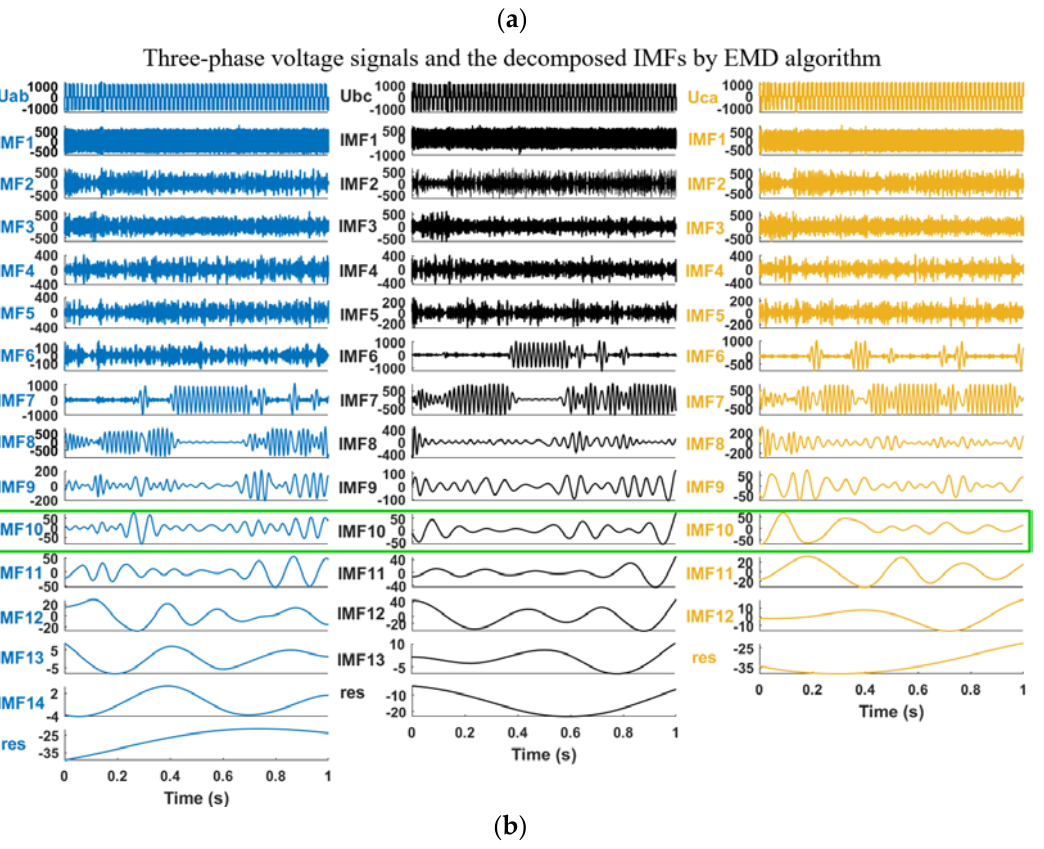
Figure 4. The decomposition results of the three-phase voltages U ab , U bc , and U ca . ( a ) MEMD; ( b ) EMD. Table 3. The timescales of the common modes extracted by MEMD.